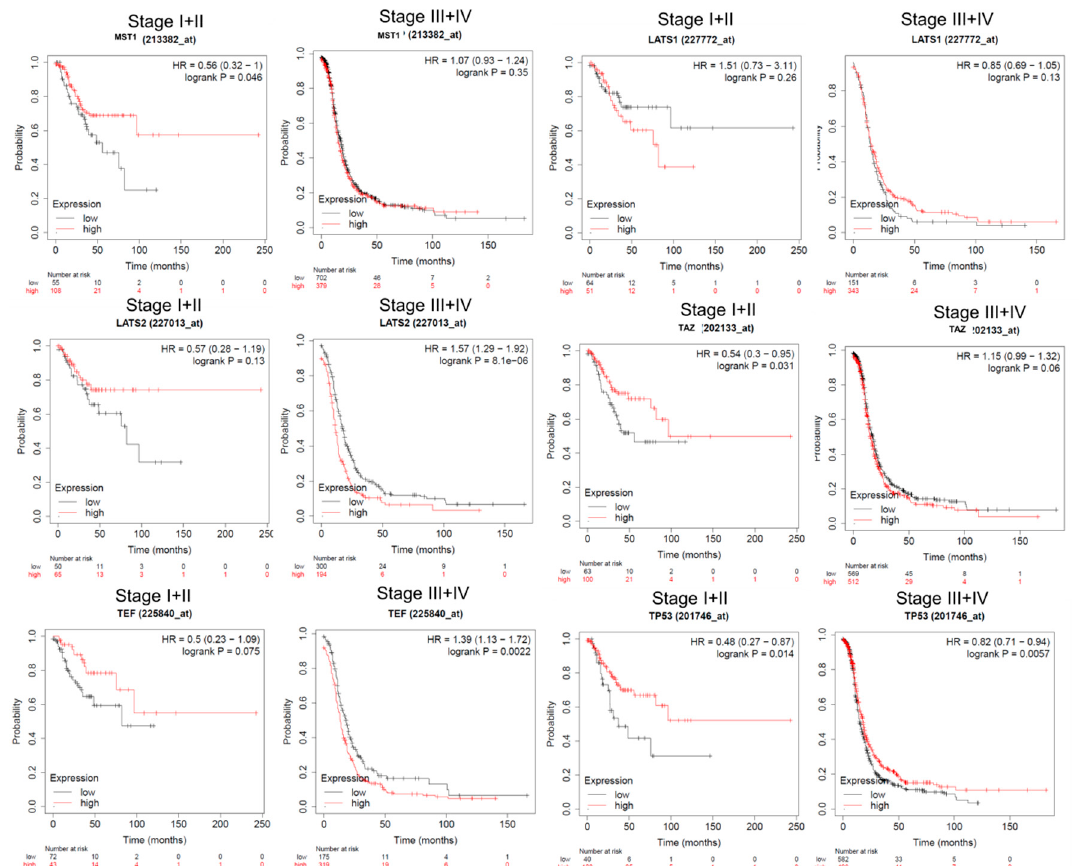
Figure 3. Progression-free survival (PFS) subgroup analysis of key Hippo signaling genes for OC patients, according to high or low expression level based on tumor stage. PFS of key Hippo signaling genes (MST1, LATS1, LATS2, TAZ, MST1, and TEF) for OC patients, grouped on stage I + II and III + IV, respectively. Survival curves of OC patients according to the expression of the Kaplan–Meier plotter (https://kmplot.com/analysis/index.php?p=service, accessed on 4 January 2021) based on TCGA patients, a log-rank test was used (LATS1 high/low, I + II p = 0.26 and III + IV p = 0.13; TP53 high/low I + II p = 0.014 and III + IV p = 0.0057; LATS2 low/high, I + II p = 0.13 and III + IV p = 8.1 × 10 − 6 ; TAZ low/high I + II p = 0.031 and III + IV p = 0.06; MST1 low/high, I + II p = 0.046 and III + IV p = 0.35; TEF high/low, I + II p = 0.075 and III + IV p = 0.0022).